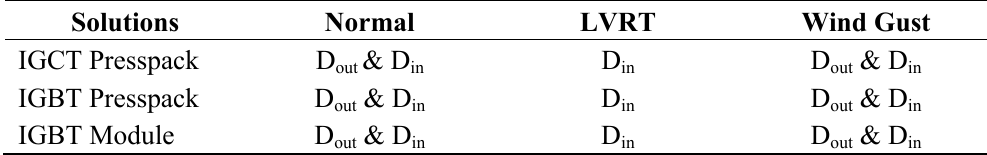
Table 5. Least stressed devices for different power device